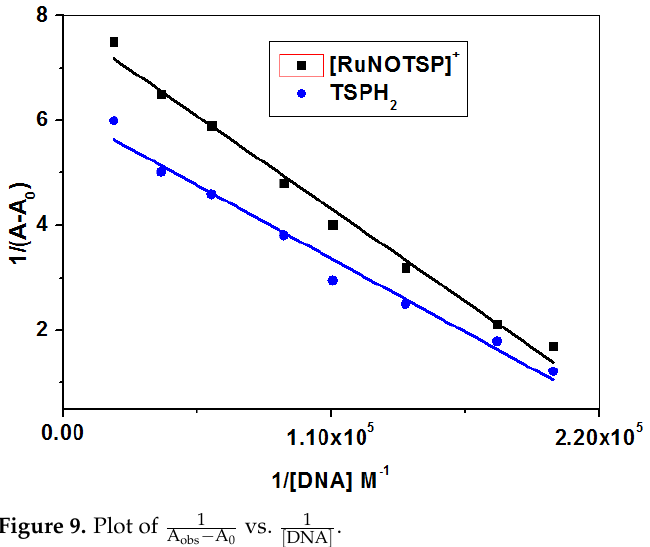
vs. (cid:2869) . (cid:2885) (cid:3173)(cid:3160)(cid:3177) (cid:2879)(cid:2885) (cid:3116) [(cid:2888)(cid:2898)(cid:2885)]